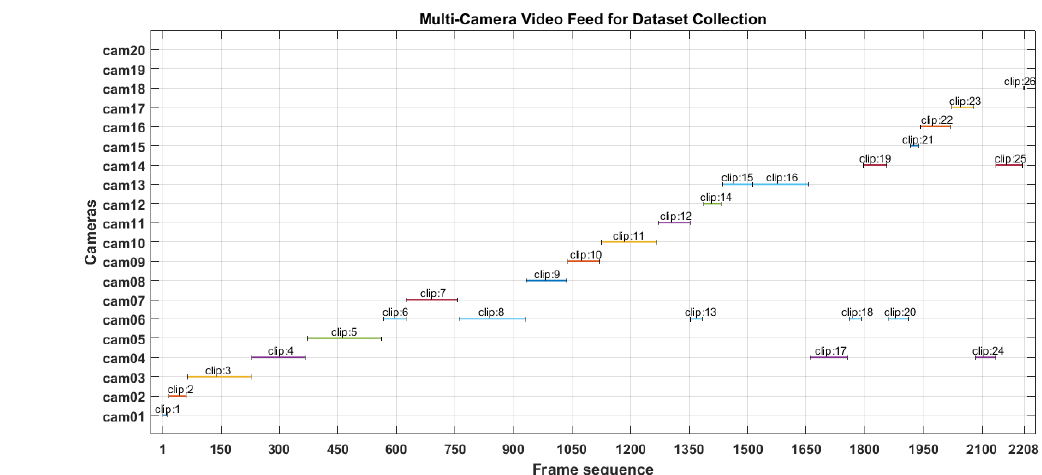
Figure 11. Multi-Camera video feed.